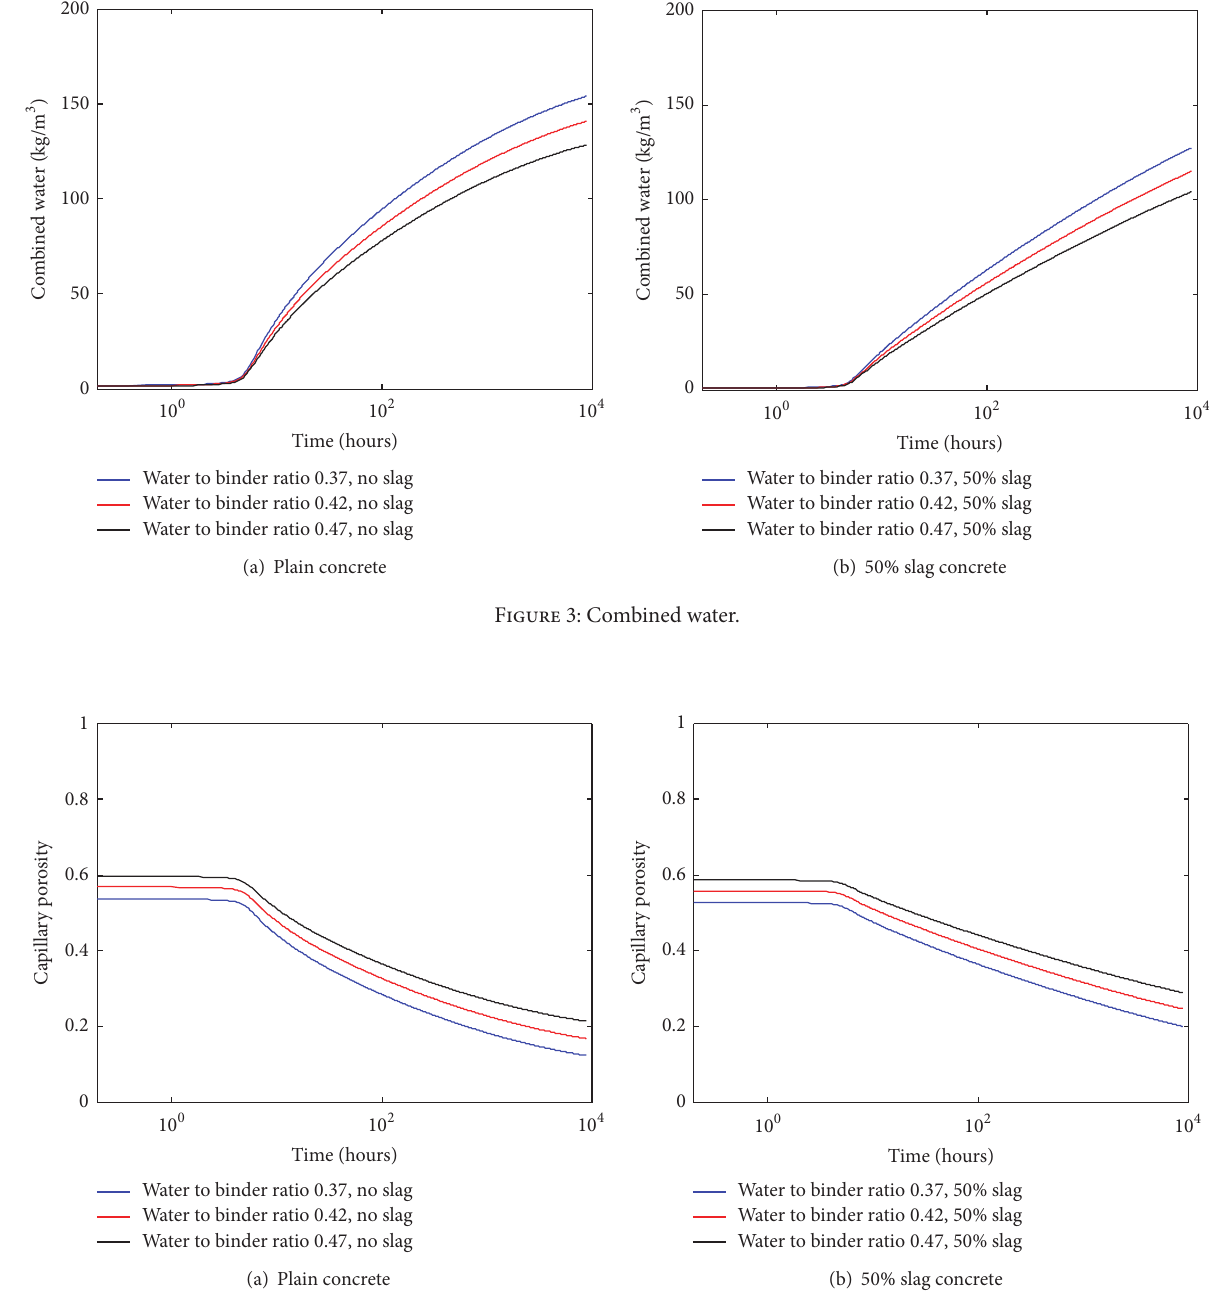
Figure 4: Capillary